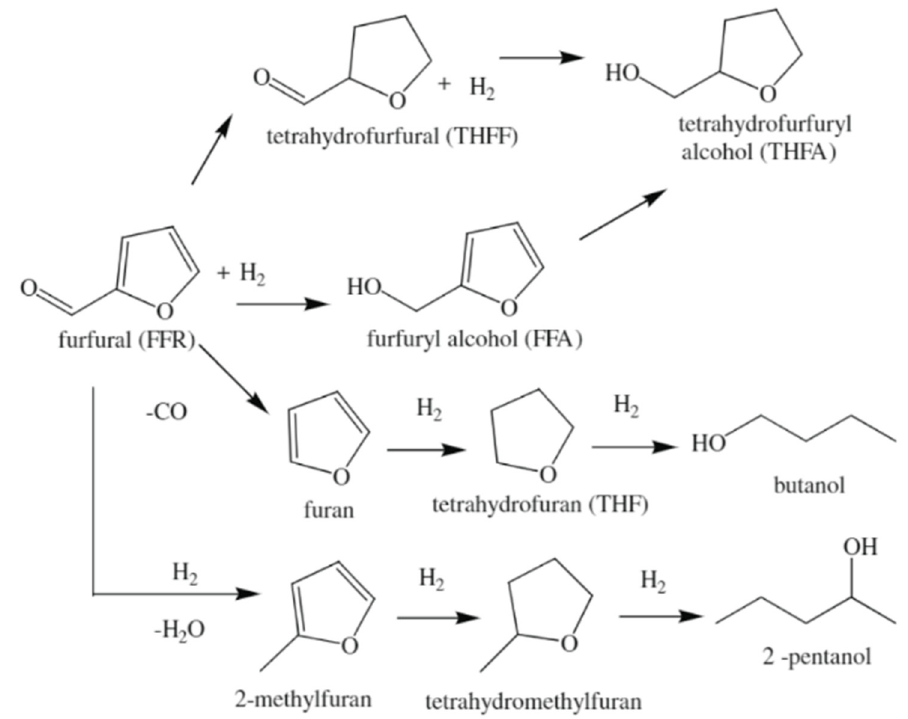
Scheme 1. Reaction pathway for FFR hydrogenation. Adapted from [61] with permission of Else- vier, copyright